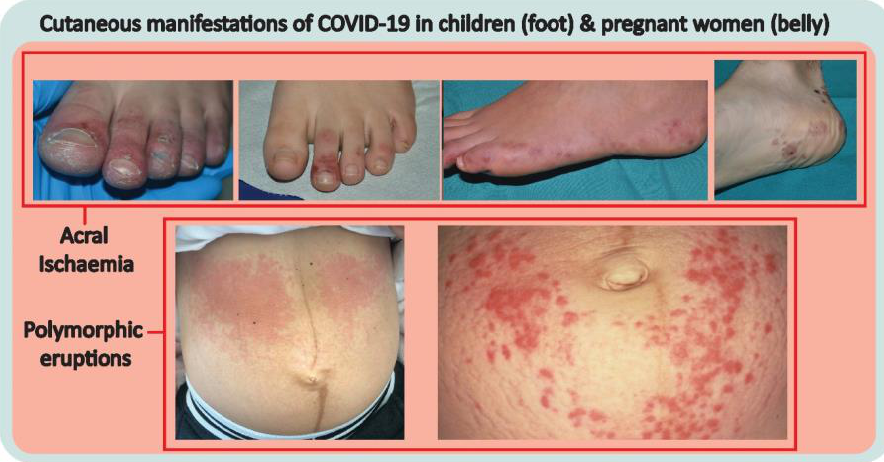
Figure 2. Cutaneous manifestations associated with COVID-19 infection in children (foot) and pregnant women (belly). Adapted with permission from [23,26].